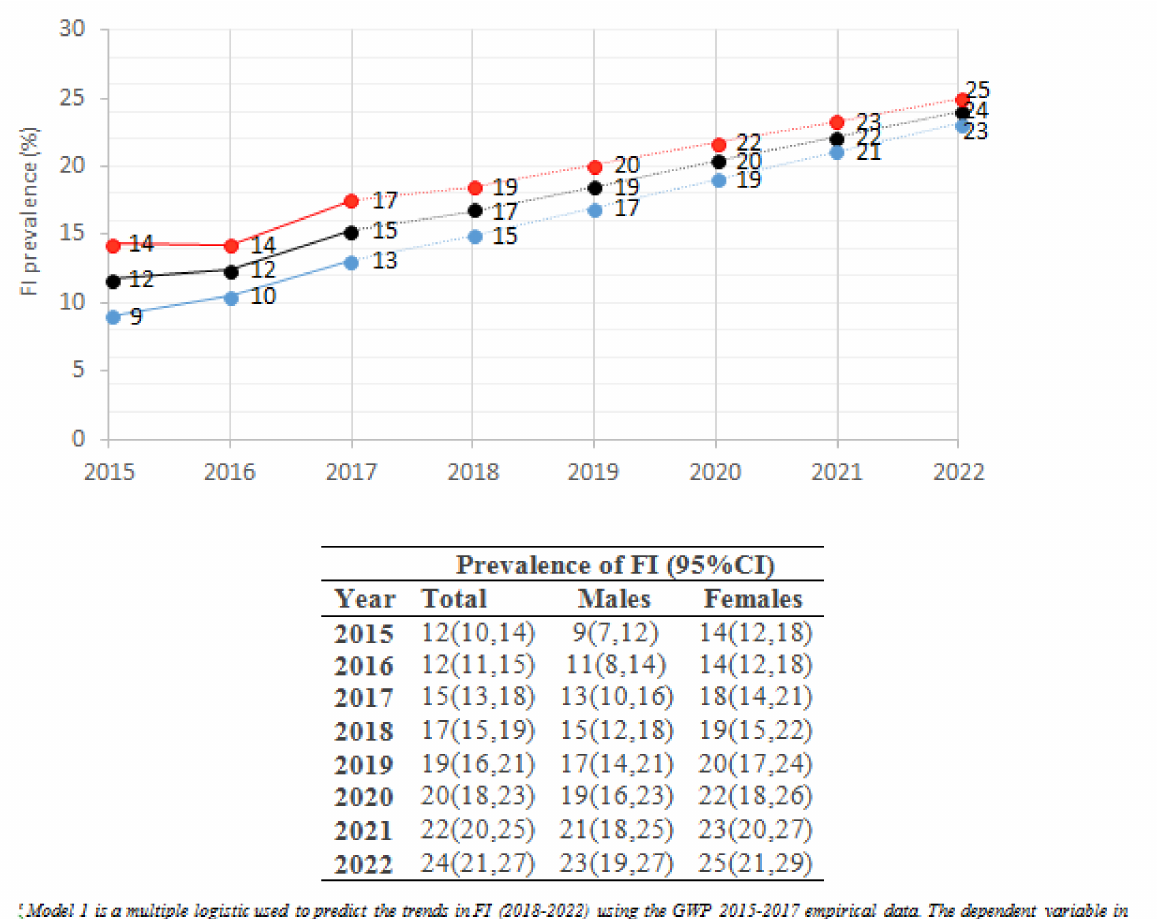
Figure 1. Trends and projections of FI (2018–2022) among Lebanese adult population using model 1 ŧ (including wave year) from GWP data (2015–2017) ‡